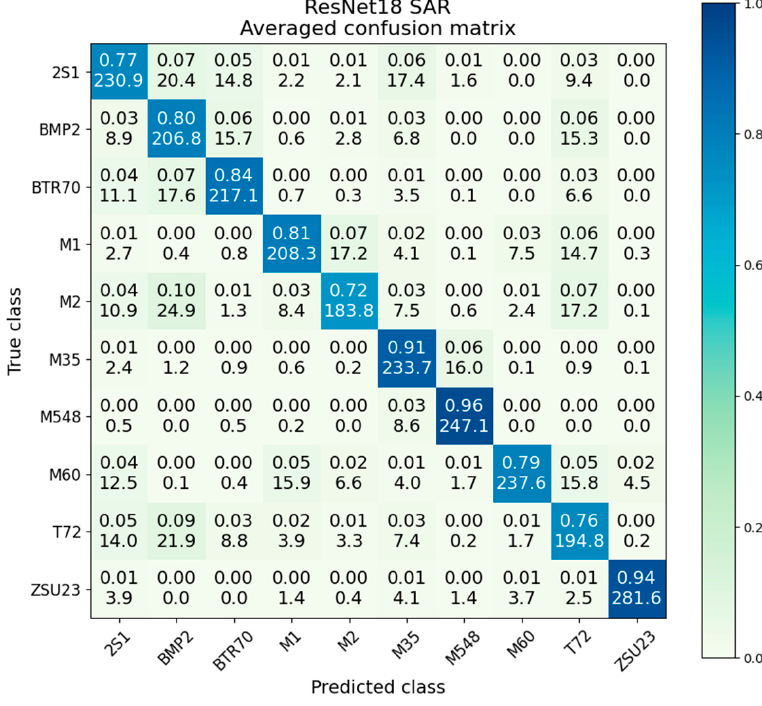
Figure 7. Averaged confusion matrix for ResNet18 on SAR data. Table 2. SAR-only ResNet18 intraclass variance (Var) and standard deviation (SD).